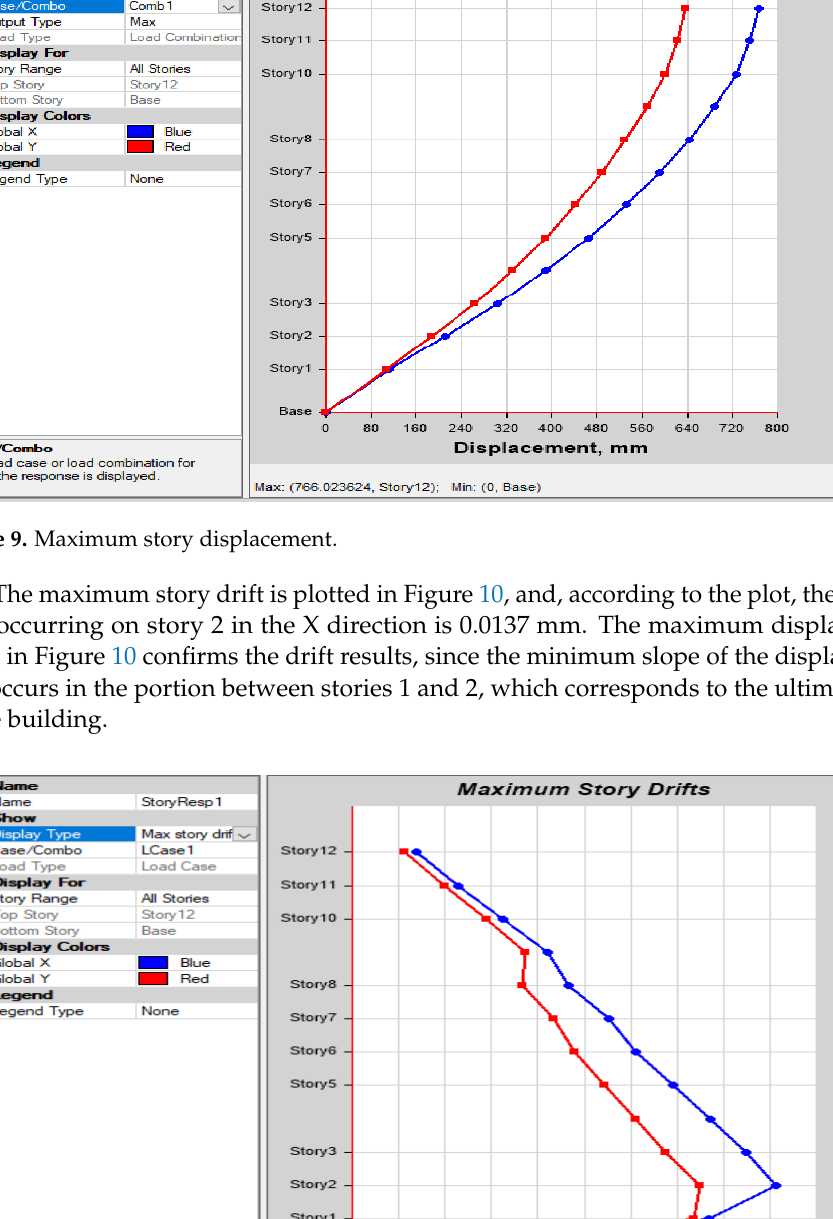
12 Figure 8. Story shears.